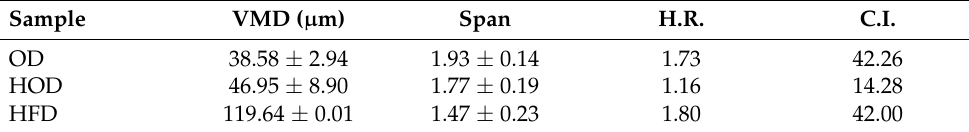
Table 1. Dimensional analysis and flow properties of the fractions with PS < 250 µ